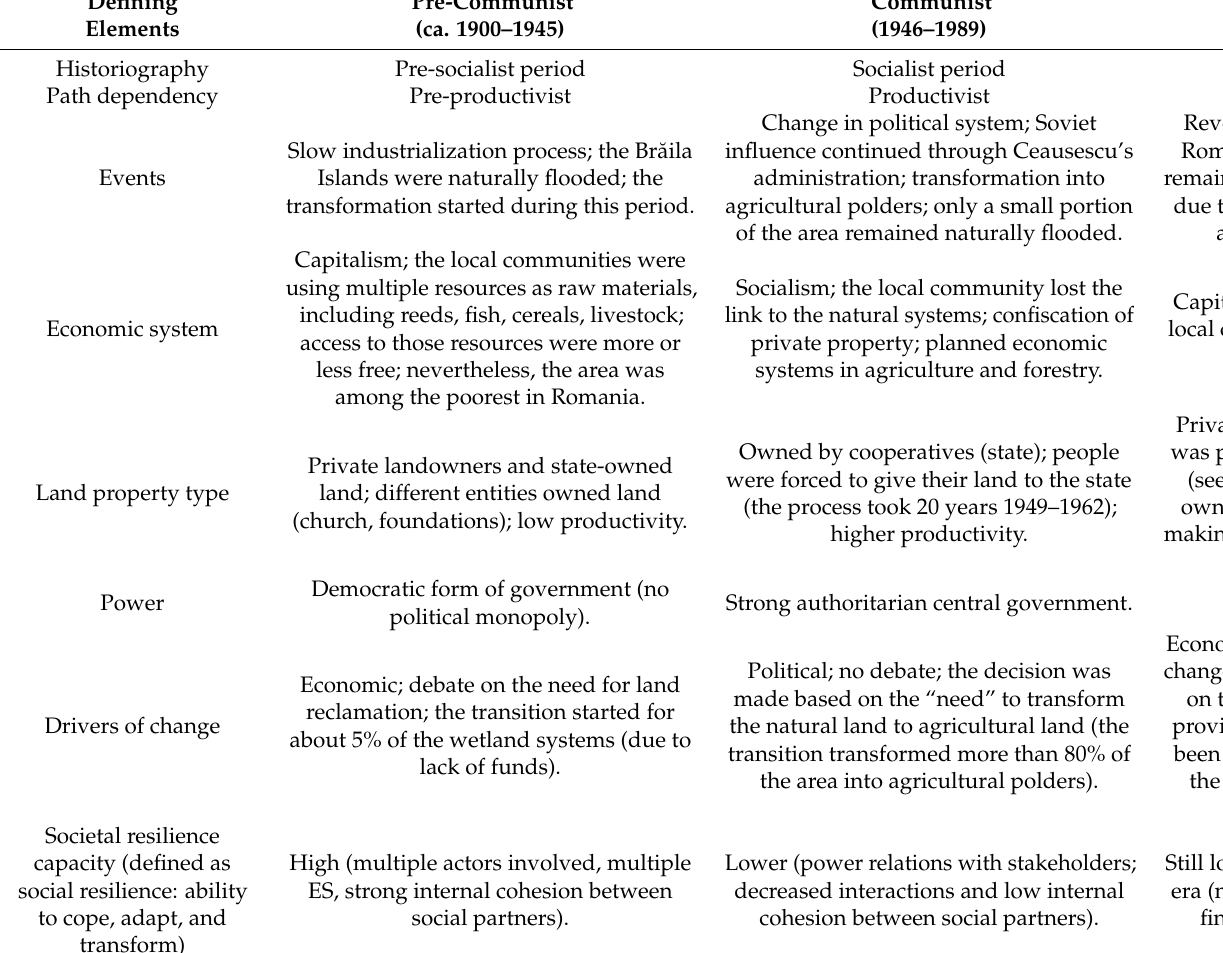
Table 1. Defining the three environmental history periods and the implications for the Br ă ila